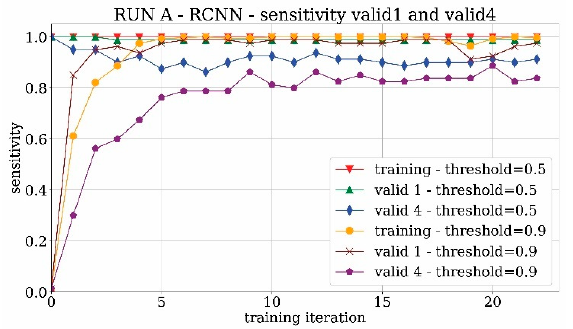
Figure 8. Sensitivity trend of RUN A with valid 1 and 4.